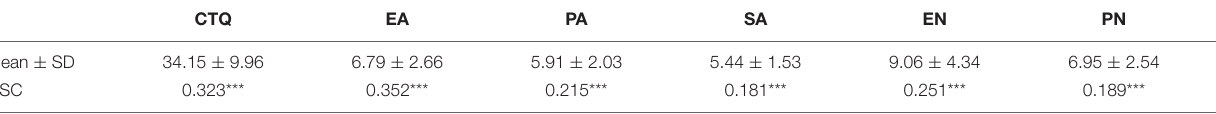
TABLE 3 | The correlations between Qi-stagnation constitution (QSC) and different types of childhood maltreatment. CTQ EA PA SA EN PN